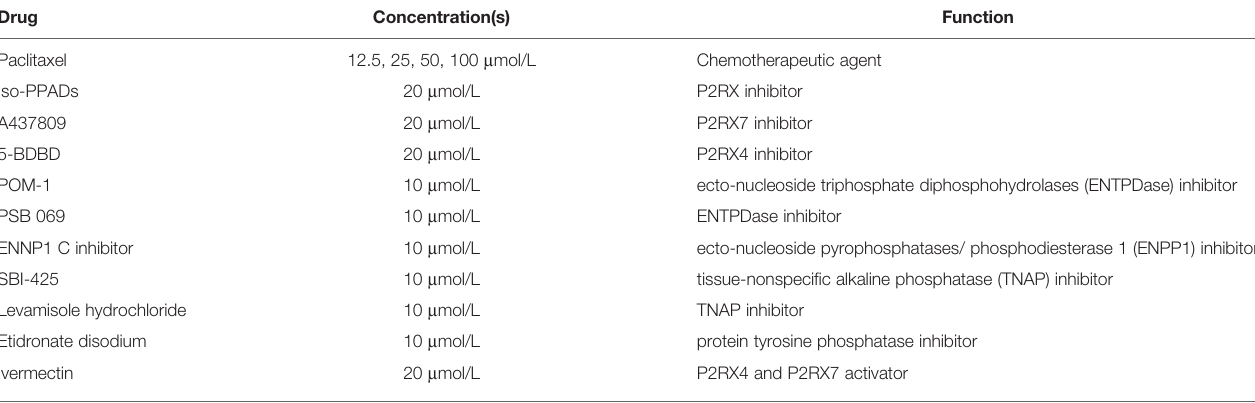
TABLE 1 | Drug concentrations and functions. The table shows the drugs administered, their concentrations applied and their functions. Drug Concentration(s)